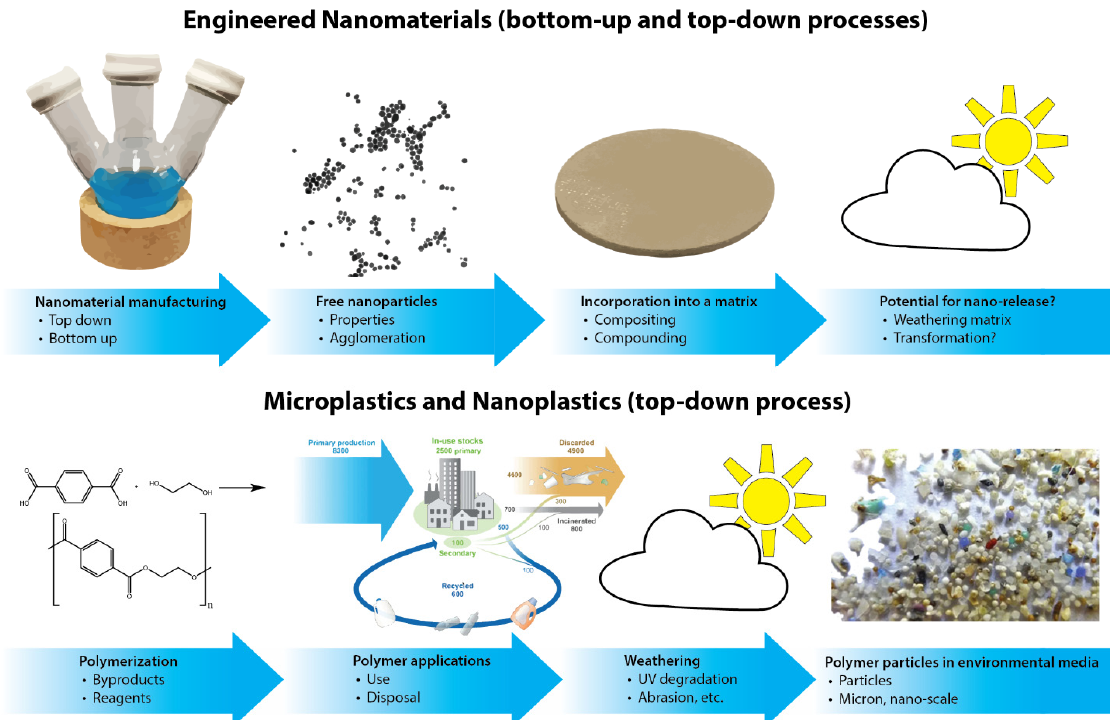
Figure 1. Particle generation of engineered nanomaterials (top) or microplastics and nanoplastics (bottom). Part of the figure (polymer applications) is adapted from reference [13].